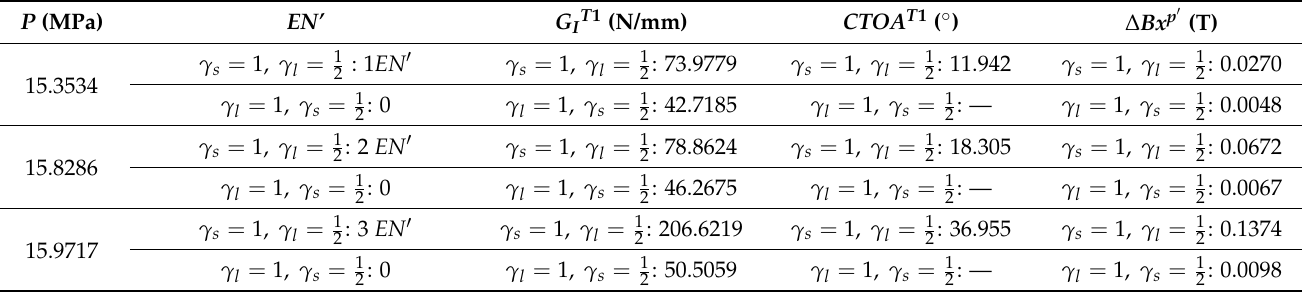
Figure 16. Third set of simulation models: l m = 3.5 mm, X = 1/2, Y = 0. ( a ) γ s = 1, γ l = 1 ( b ) γ l = 1, γ s = 1 . 2 Table 7. Changes of the interference parameters γ l and γ s for the first set of the simulation